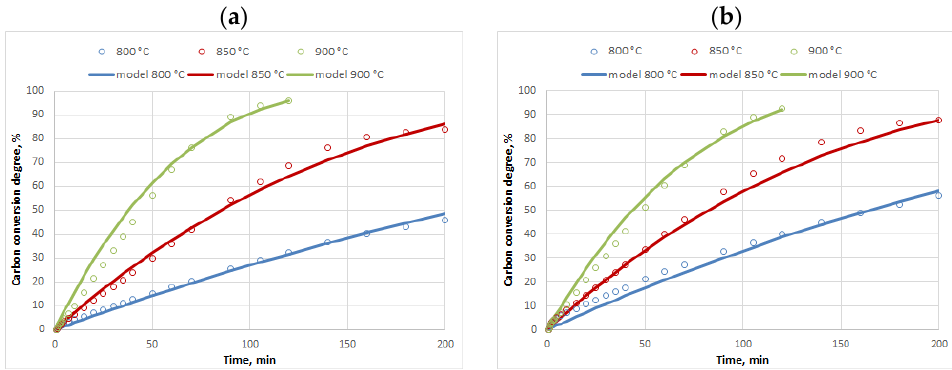
Figure 5. Experimental and model results for degree of carbon conversion at time X ( t ) for ( a ) the 90:10 blend and ( b ) the 67:33 blend.